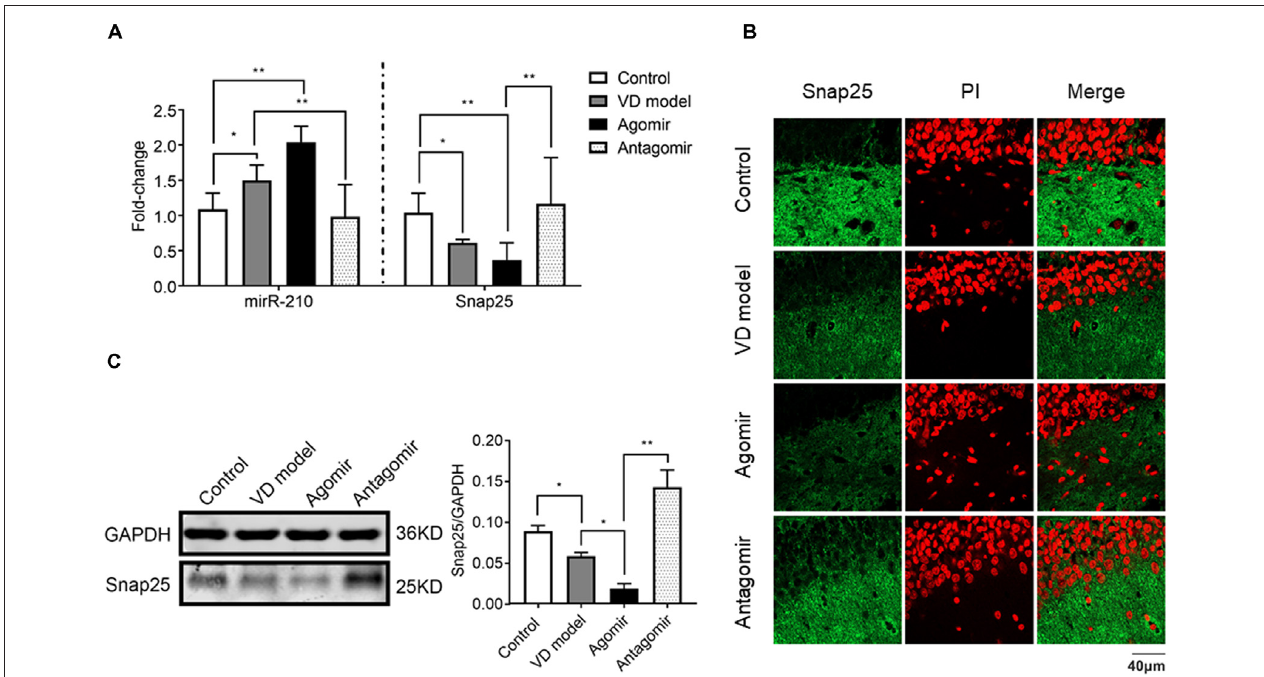
FIGURE 6 | ICV injection of miRNA-210 antagomir effectively restore hippocampal snap25 expression in VD model ( n = 6/group). (A) miR-210-5p and Snap25 mRNA expression detected by qPCR ( n = 6/group). (B) Snap25 protein expression visualized through immunofluorescence. (C) Snap 25 protein expression in hippocampus tested by western blot ( n = 6/group). Data are shown as mean ± SD values, and statistical significance between both groups is defined as ∗ p < 0.05; ∗∗ p <